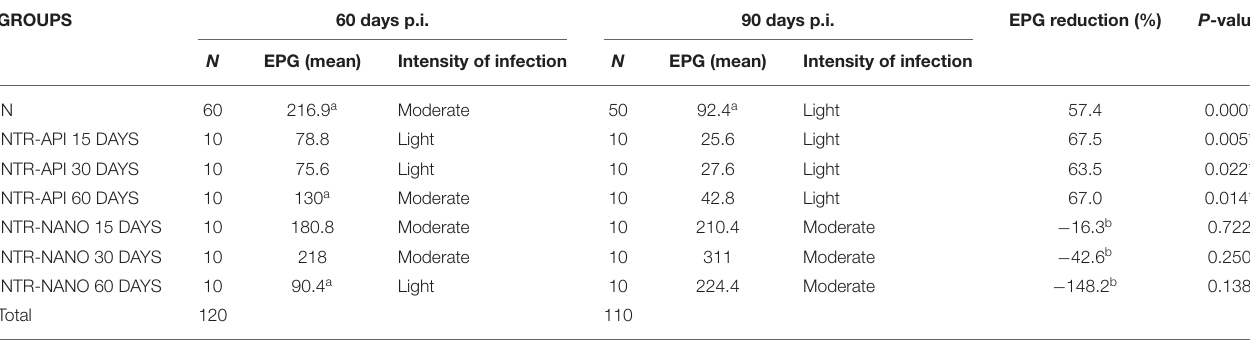
TABLE 1 | Average amount of eggs per gram of feces (EPG) obtained from mice infected with S. mansoni in two periods: 60 days and 90 days after schistosomal infection. GROUPS 60 days